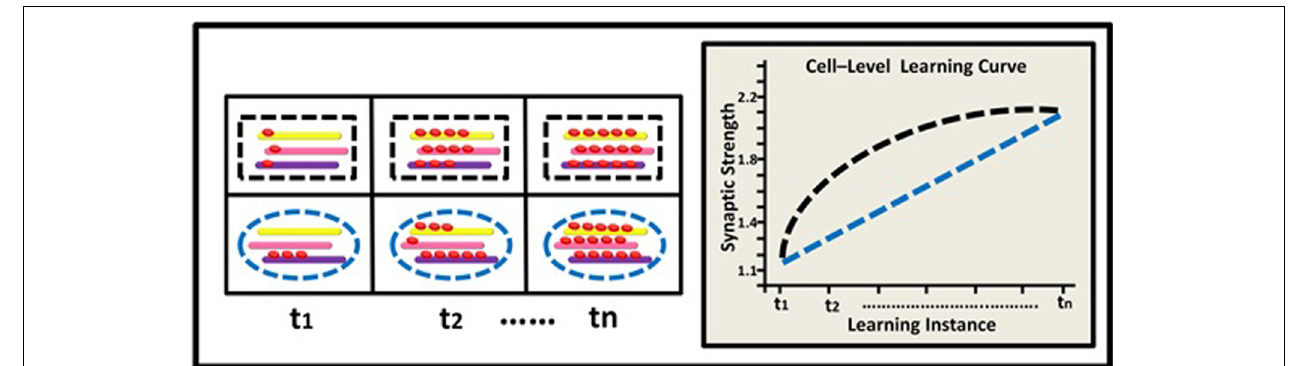
FIGURE 3 | Epigenetic dynamics during learning can shape the neural learning-curve at the single neuron’s gene-network level. At (t1), two types of neurons (black rectangle and blue ellipse) have similar overall basal methylation level (depicted by a 3-gene network: yellow, pink, and purple rods). During learning, (t2–tn) the two neurons exhibit different patterns of